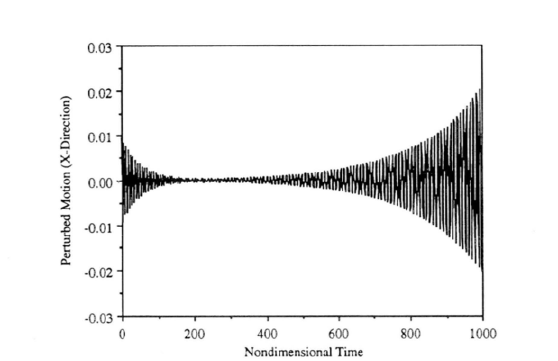
FIGURE 14 X-direction perturbation versus nondi mensional time (w = 0.7). Initial conditions: i o(O) = .90(0) = 0.01, i o(O) = Yo(O) = 0, cf>s) = 3.13, cf>s2 = 3.15, cf» (0) = cf>2(0) = 0.01, ~) (0) = ~2(0) = 0, m = 0.005, R = 0.001, and {3 ' = .01.